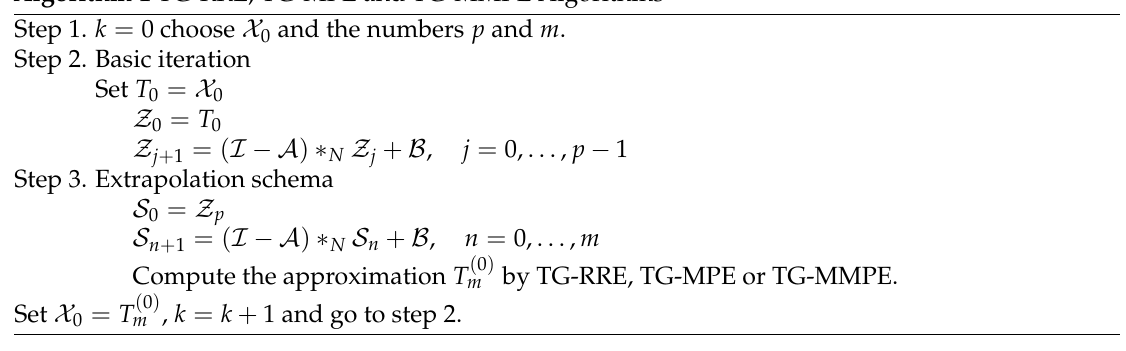
Algorithm 1 TG-RRE, TG-MPE and TG-MMPE